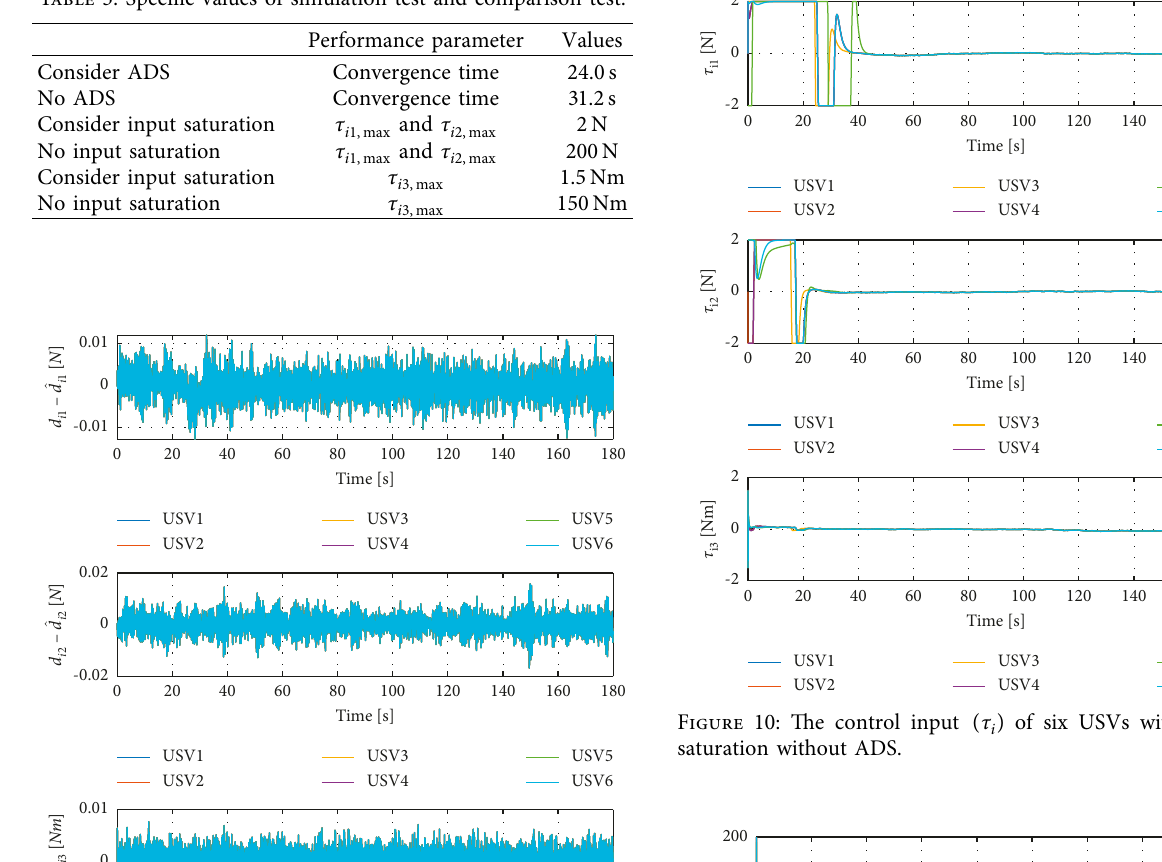
) of six USVs via MDA. i